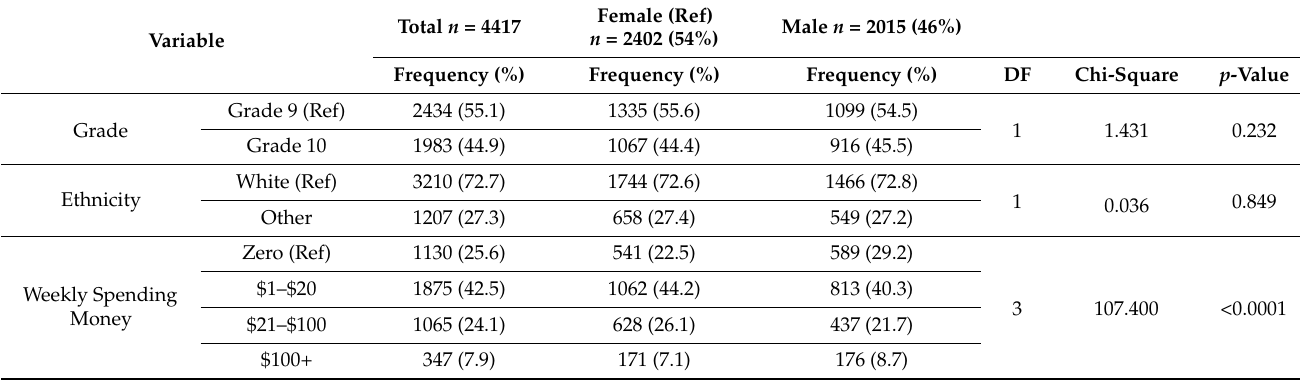
Table 2. Descriptive Statistics for Baseline Student-Level Characteristics for the sample ( n = 4417) from Year 5 (2016–2017) of the COMPASS study.